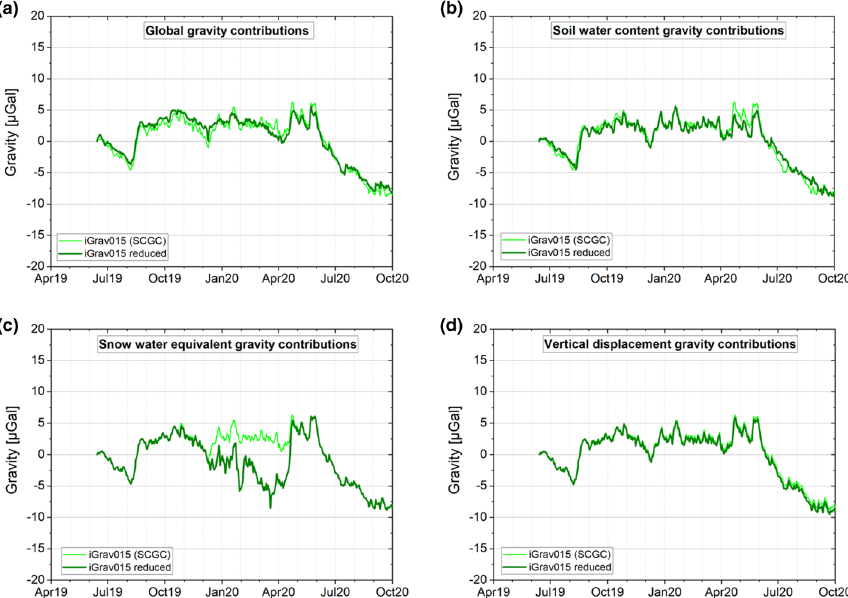
Fig. 18 Reductions of environmental gravity contributions for iGrav015 (SCGC, 1.3 years observation period) for a global gravity contributions; b soil water content variations; c snow water equivalent, and d vertical surface displacement